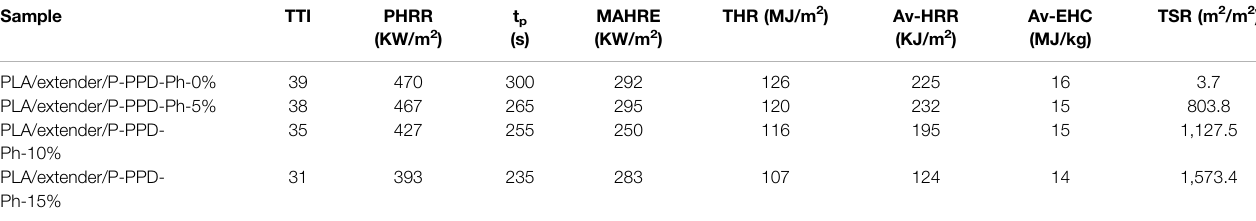
TABLE 2 | Cone calorimeter test data of PLA/P-PPD-Ph-conjugated fl ame-retardant composites.